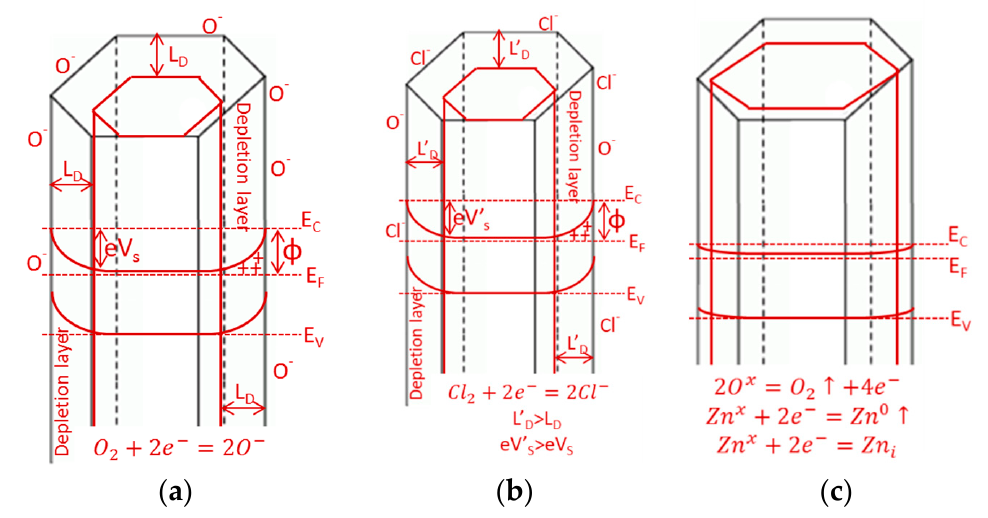
Figure 12. Scheme of chlorine detection steps on ZnO surfaces: ( a ) O 2 chemisorption, ( b ) partial O 2 desorption and Cl 2 adsorption, ( c ) sublimation of ZnO. L D —Debye length, E C —Conduction band energy, E F —Fermi level and E V —Valence band energy.